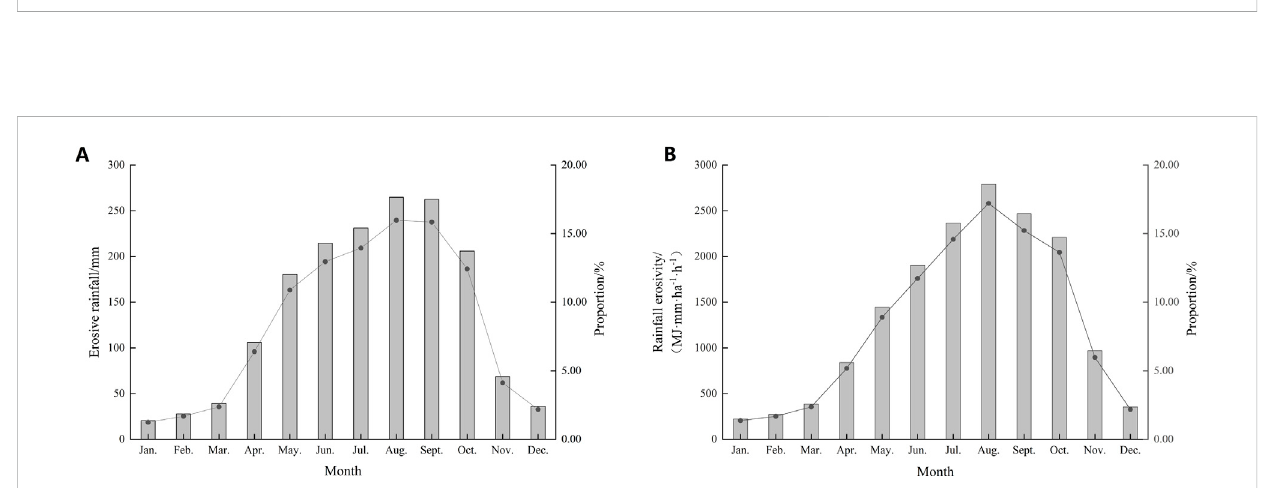
FIGURE 3 Distribution of monthly erosive rainfall and rainfall erosivity in the Nandu River